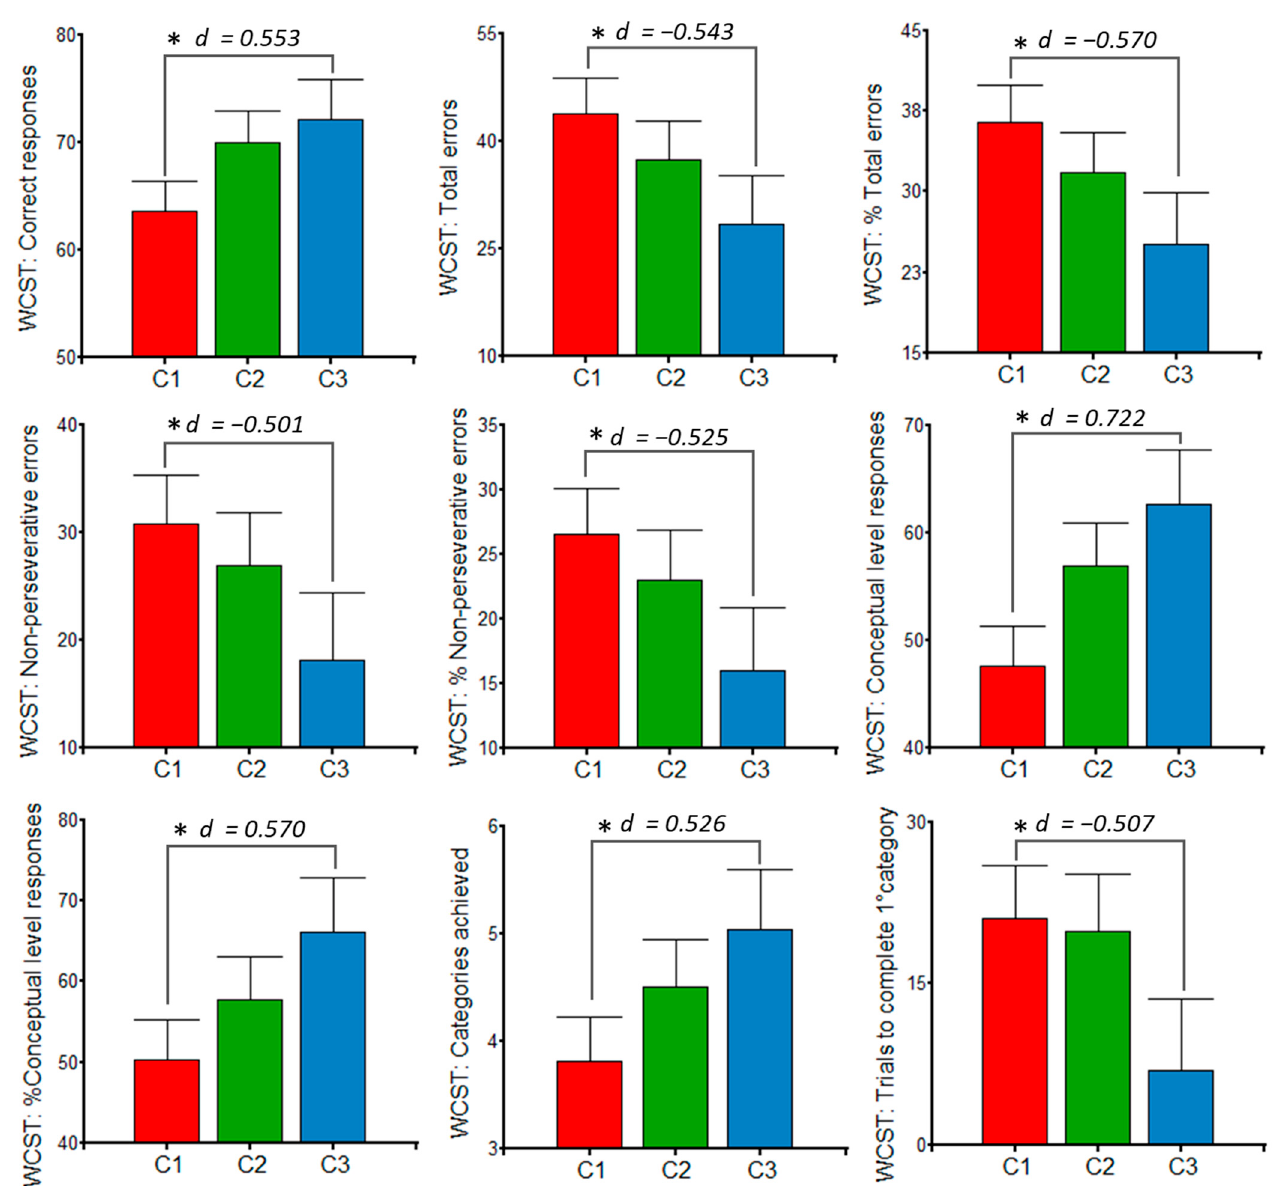
Figure 4. Wisconsin Card Sorting Test (WCST) scores according to polyphenolic intake clusters (>20 mg/d). ANCOVA models were carried out with Fisher’s post hoc contrast and adjusted by educational level, postpartum days, parity, dietary indices (macronutritional, phytochemical, and energetic), and insomnia. C1: n = 34; C2: n = 24; C3: n = 17. D = Cohen’s d for effect size; * p < 0.05.